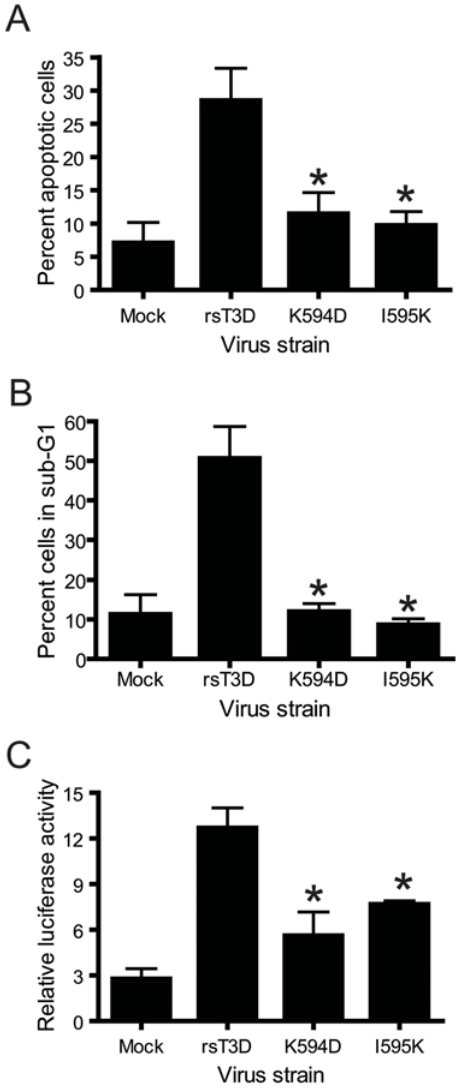
Figure 4. K594D and I595K are apoptosis-defective. (A) HeLa cells were infected with rsT3D or the indicated Q mutant at an MOI of 100 PFU/cell. Following 48 h incubation, the percentage of apoptotic cells was determined after staining with acridine orange. Results are expressed as the mean percentage of apoptotic cells for triplicate samples. Error bars indicate SD. *, P , 0.05 as determined by Student’s t - test in comparison to rsT3D. (B) HeLa cells were infected with rsT3D or the indicated Q mutant at an MOI of 100 PFU/cell. Following 48 h incubation, the percentage of cells with less than G1 DNA content (sub- G1) was quantified by staining with propidium iodide. Results are expressed as the mean percentage of sub-G1 cells for triplicate samples. Error bars indicate SD. *, P , 0.05 as determined by Student’s t -test in comparison to rsT3D. (C) 293T cells were co-transfected with pNF- k B-Luc and pRenilla-Luc 24 h prior to adsorption with rsT3D or the indicated Q mutant at an MOI of 100 PFU/cell. Luciferase activity in cell lysates was determined at 24 h post-infection. Results are presented as the ratio of normalized luciferase activity from infected cell lysates to that from mock-infected lysates for triplicate samples. Error bars indicate SD. *, P , 0.05 as determined by Student’s t -test in comparison to rsT3D.